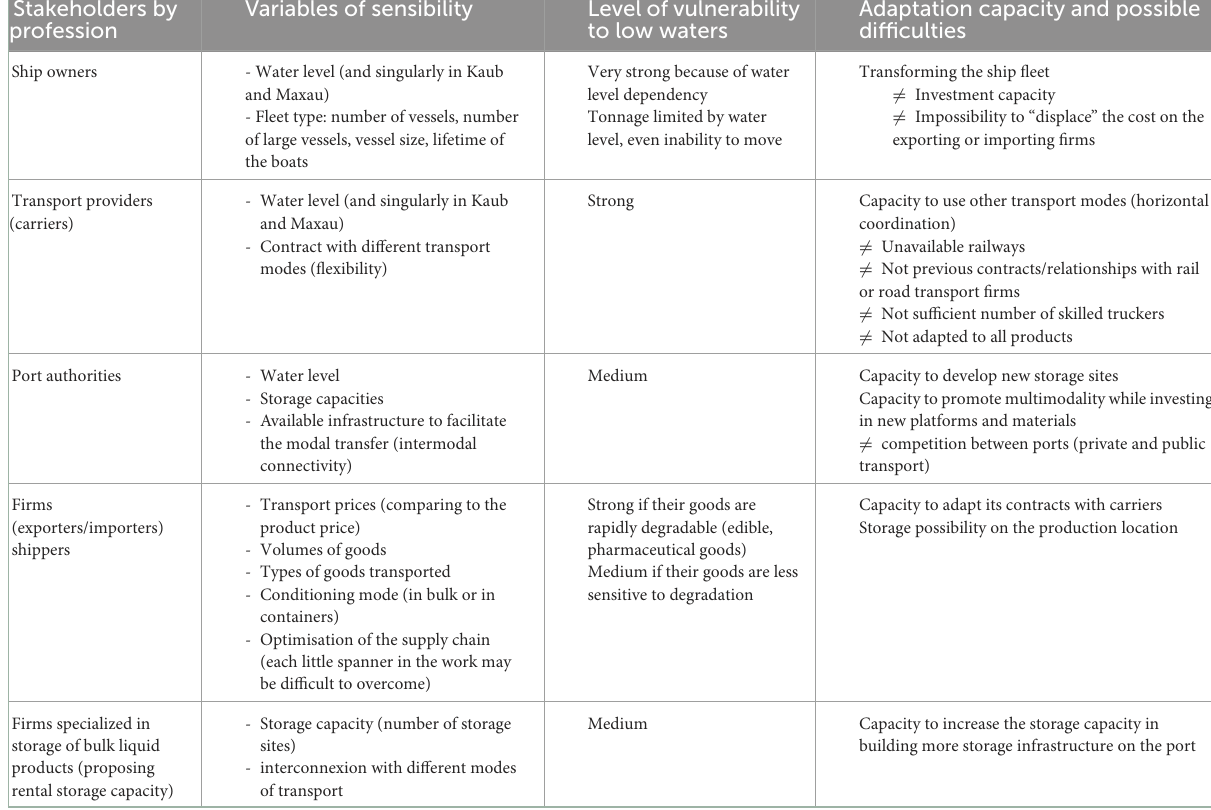
TABLE 1 Sensibility, vulnerability and adaptation capacity according to the types of stakeholders. Stakeholders by